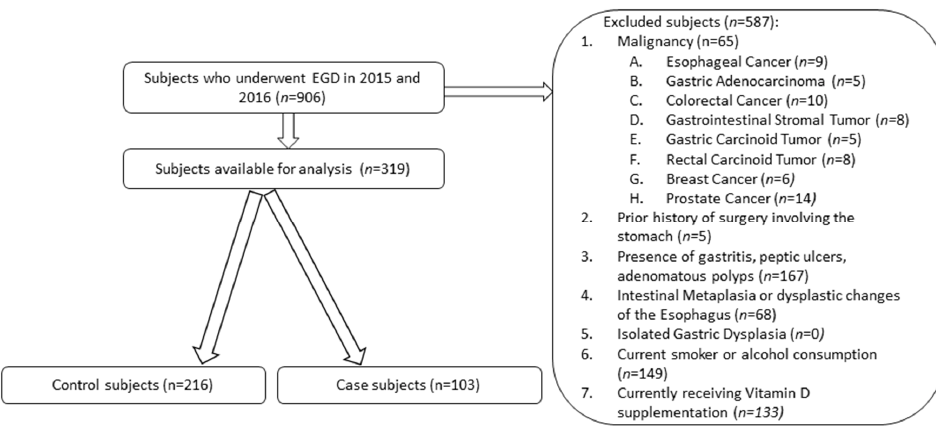
Figure 1. Flowchart describing the inclusion and exclusion criteria applied to the